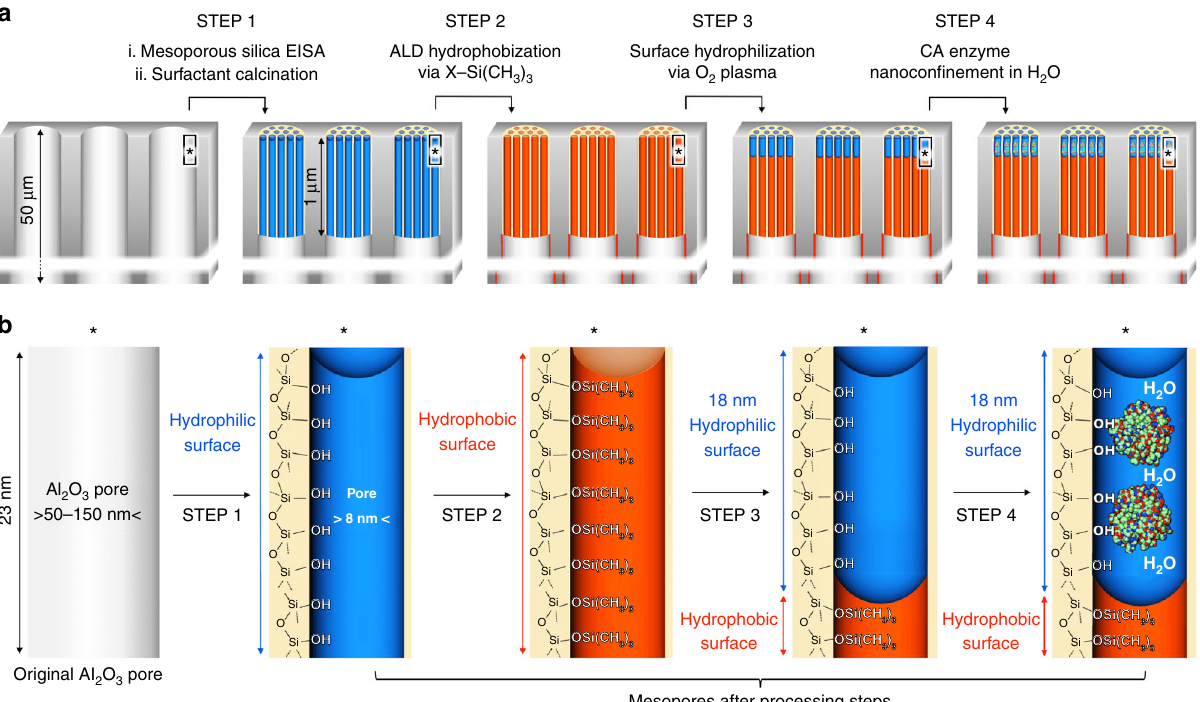
Fig. 4 Design steps of the enzymatic liquid membrane. Beginning with a 50- µ m-thick Anodisc support, Step 1 comprises the formation of oriented arrays of 8 nm diameter cylindrical silica mesopores within the 50 – 150 nm diameter Anodisc pores via evaporation-induced self-assembly followed by calcination to remove the P123 surfactant. In Step 2, three alternating cycles of atomic layer deposition (ALD) of HMDS ((CH 3 ) 3 -Si-N-Si(CH 3 ) 3 ) + TMCS (Cl-Si(CH 3 ) 3 ) followed by water are conducted to convert the hydrophilic silanol-terminated mesopore surfaces to hydrophobic Si-O-Si(CH 3 ) 3 surfaces throughout the 1 µ m length of the mesopore. In Step 3 a remote oxygen plasma treatment is used to regenerate hydrophilic silanol groups to a depth of 18 nm on the top surface. In Step 4 an aqueous solution of CA is introduced on the top surface. Through capillary condensation, water plus enzymes fi ll the mesoporous silica array. a images represent the processing steps and b images represent the corresponding surface